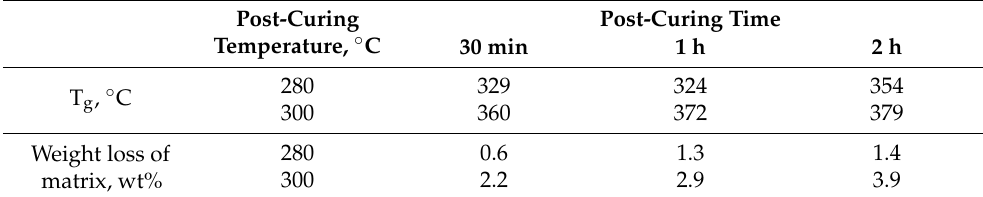
Figure 7. DMA of CFRP with NOV 25 (CFRP manufacturing temperature is 220 °C). Table 2. Selecting of post-curing